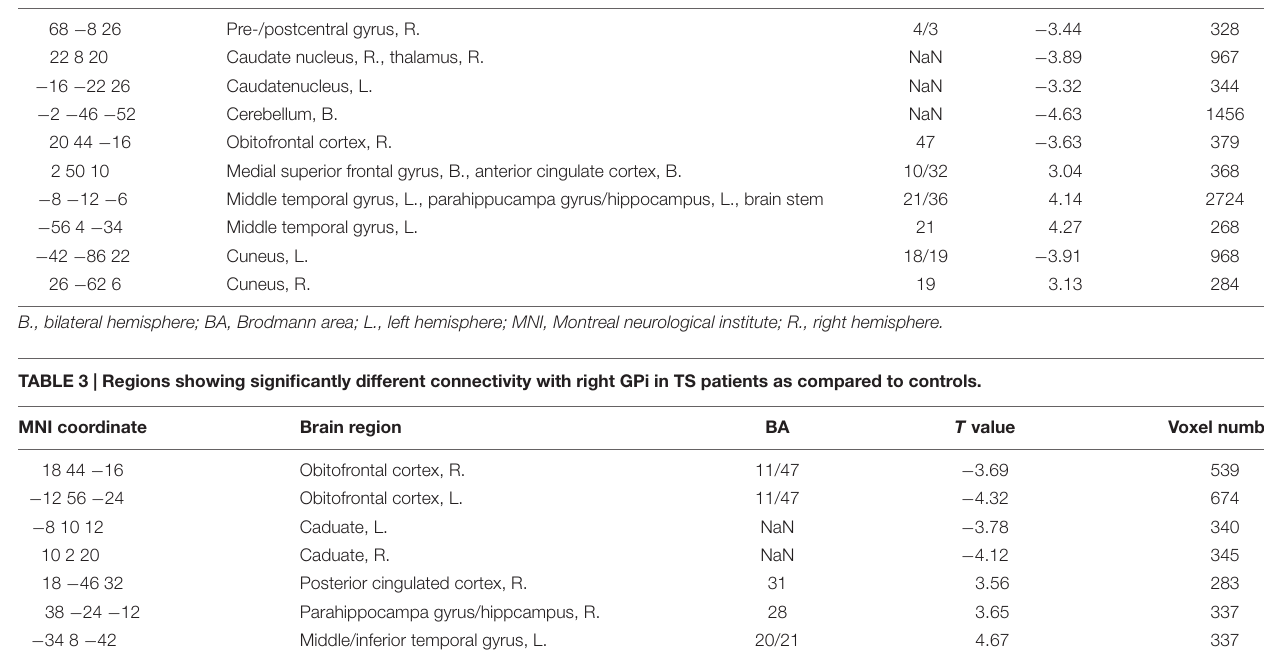
Middle/inferior temporal gyrus, L. Middle temporal/occipital gyrus,